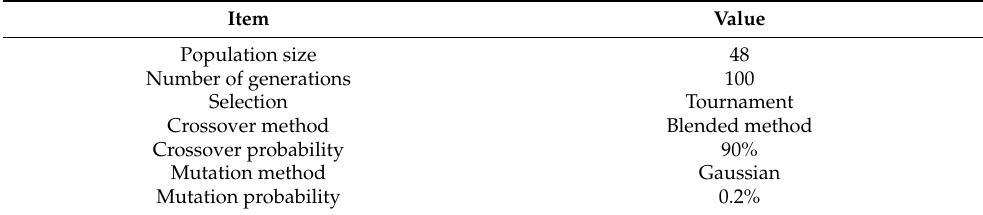
Table 5. Settings of the NSGA-II for the optimization case